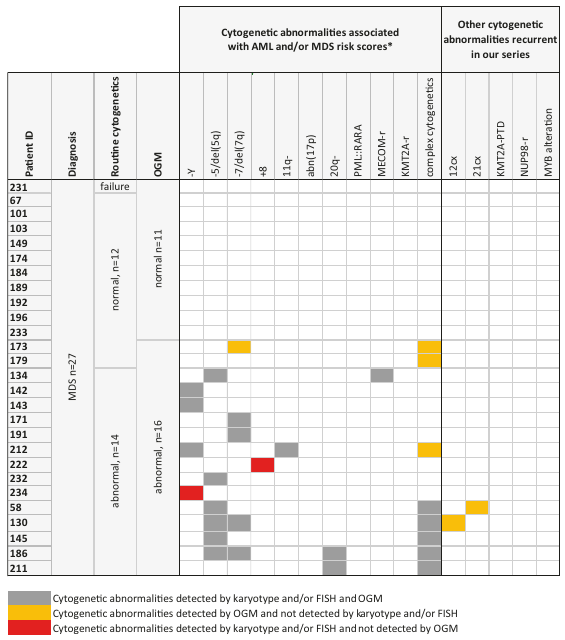
OGMCytogene(cid:2)c abnormali(cid:2)es detected by karyotype and/or FISH and OGM Cytogene(cid:2)c abnormali(cid:2)es detected by OGM and not detected by karyotype and/or FISH Cytogene(cid:2)c abnormali(cid:2)es detected by karyotype and/or FISH and not detected by